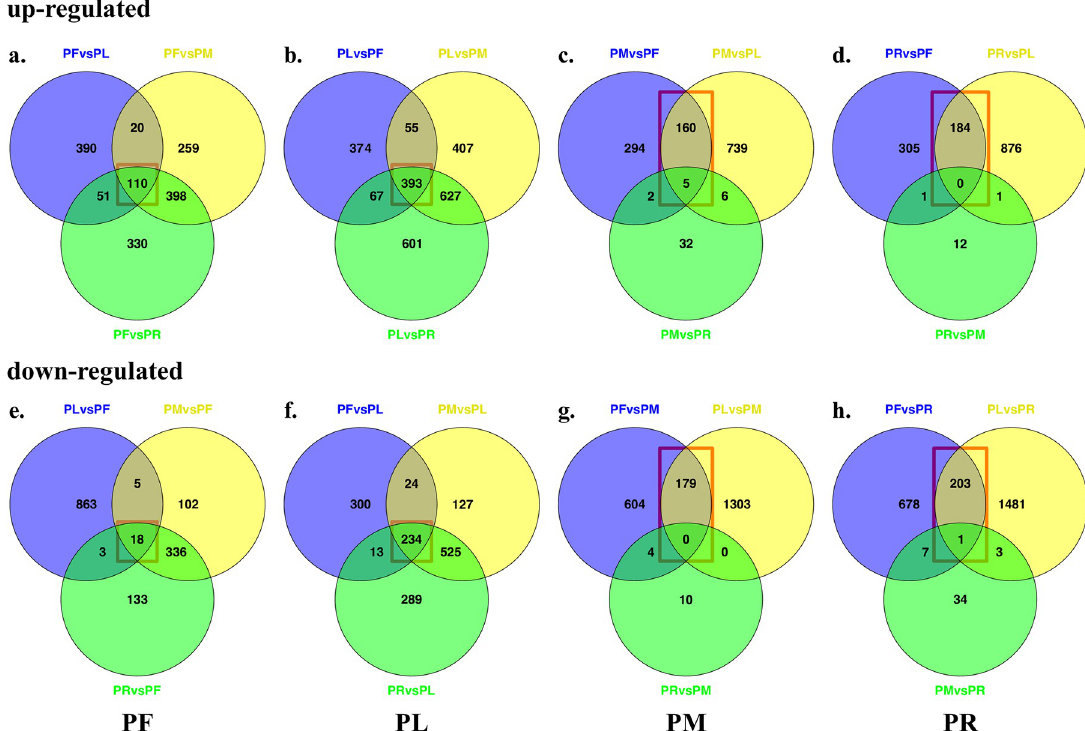
Fig 5. Venn gram analyses of DETs identification in each pairwise comparison among tissues. The top four diagrams (a, b, c, d) are the number of up-regulated transcripts in certain tissue from three pairwise comparisons; the bottom four diagrams (e, f, g, h) are the number of down-regulated transcripts in certain tissue from three pairwise comparisons. a and e are DETs in inflorescence (PF), b and f are DETs in leaf (PL), c and g are DETs in shoot meristem (PM), d and h are DETs in rhizome (PR). Red boxes are the number of tissue- specific DETs for the following